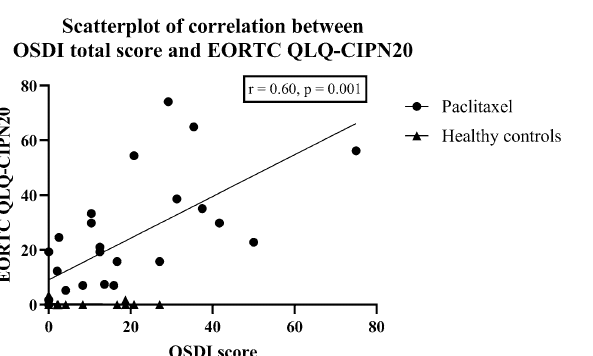
Figure 4. Relationship between ocular surface discomfort and peripheral neuropathy symptoms. Scatterplots of the association between Ocular Surface Disease Index (OSDI) scores with The European Organization for Research and Treatment of Cancer Quality of Life Questionnaire in Chemotherapy-induced Peripheral Neuropathy Questionnaire scale (EORTC QLQ-CIPN20) in paclitaxel-treated patients and healthy